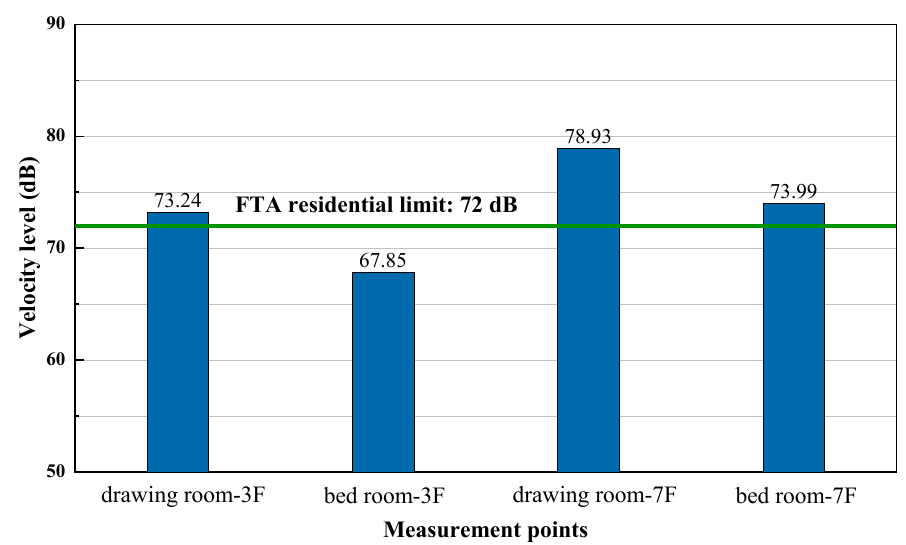
14 of 26 Table 5. Annoyance assessment results obtained by the (Mean + 2σ) method.